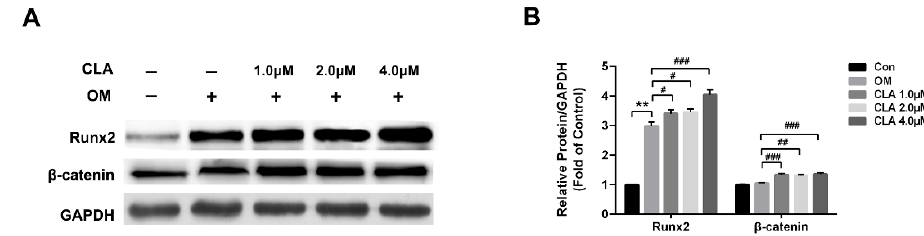
Figure 4. Expression of Runx2 and β -catenin in hBMSCs. Cells were maintained in growth medium, or induced for osteoblast differentiation in the presence or absence of different concentrations of CLA for 15 d. ( A ) Protein expression detected by Western blotting; ( B ) Quantitative analysis for protein expression. Compared to Con, data were significantly different at ** p < 0.01; compared to OM, data were significantly different at # p < 0.05, ## p < 0.01, ### p < 0.001.